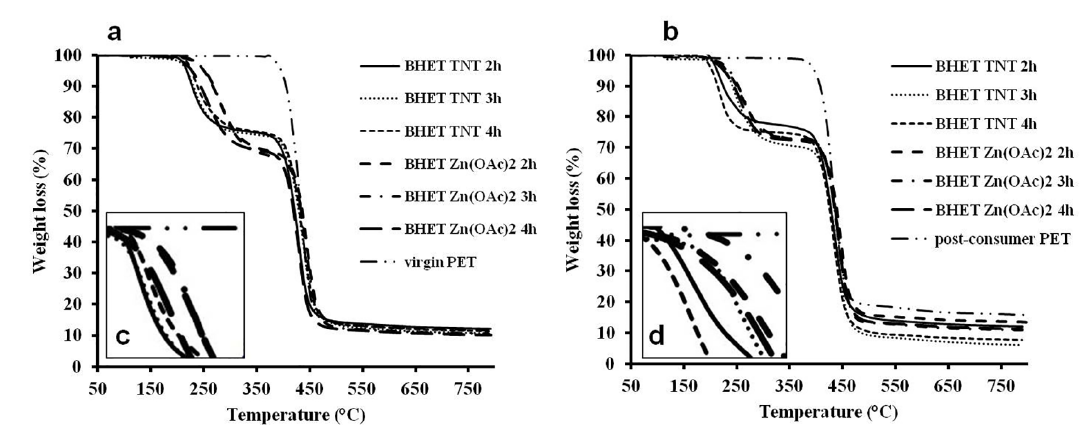
Figure 6. TGA curves for the starting material and BHET obtained from: a) virgin PET, b) post-consumer PET, c) increased image for first stage weight loss for BHET from virgin PET and d) increased image for first stage weight loss for BHET from post-consumer PET. Table 1. Degradation temperature at 5% weight loss, weight loss for the 1º and 2º degradation stages, ash content of TGA results obtained for both starting material and BHET from virgin and post-consumer PET for different reaction times.